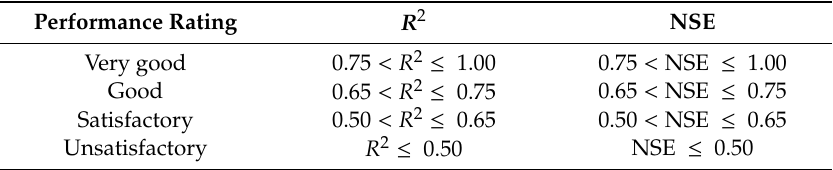
Table 4. Performance ratings for adopted